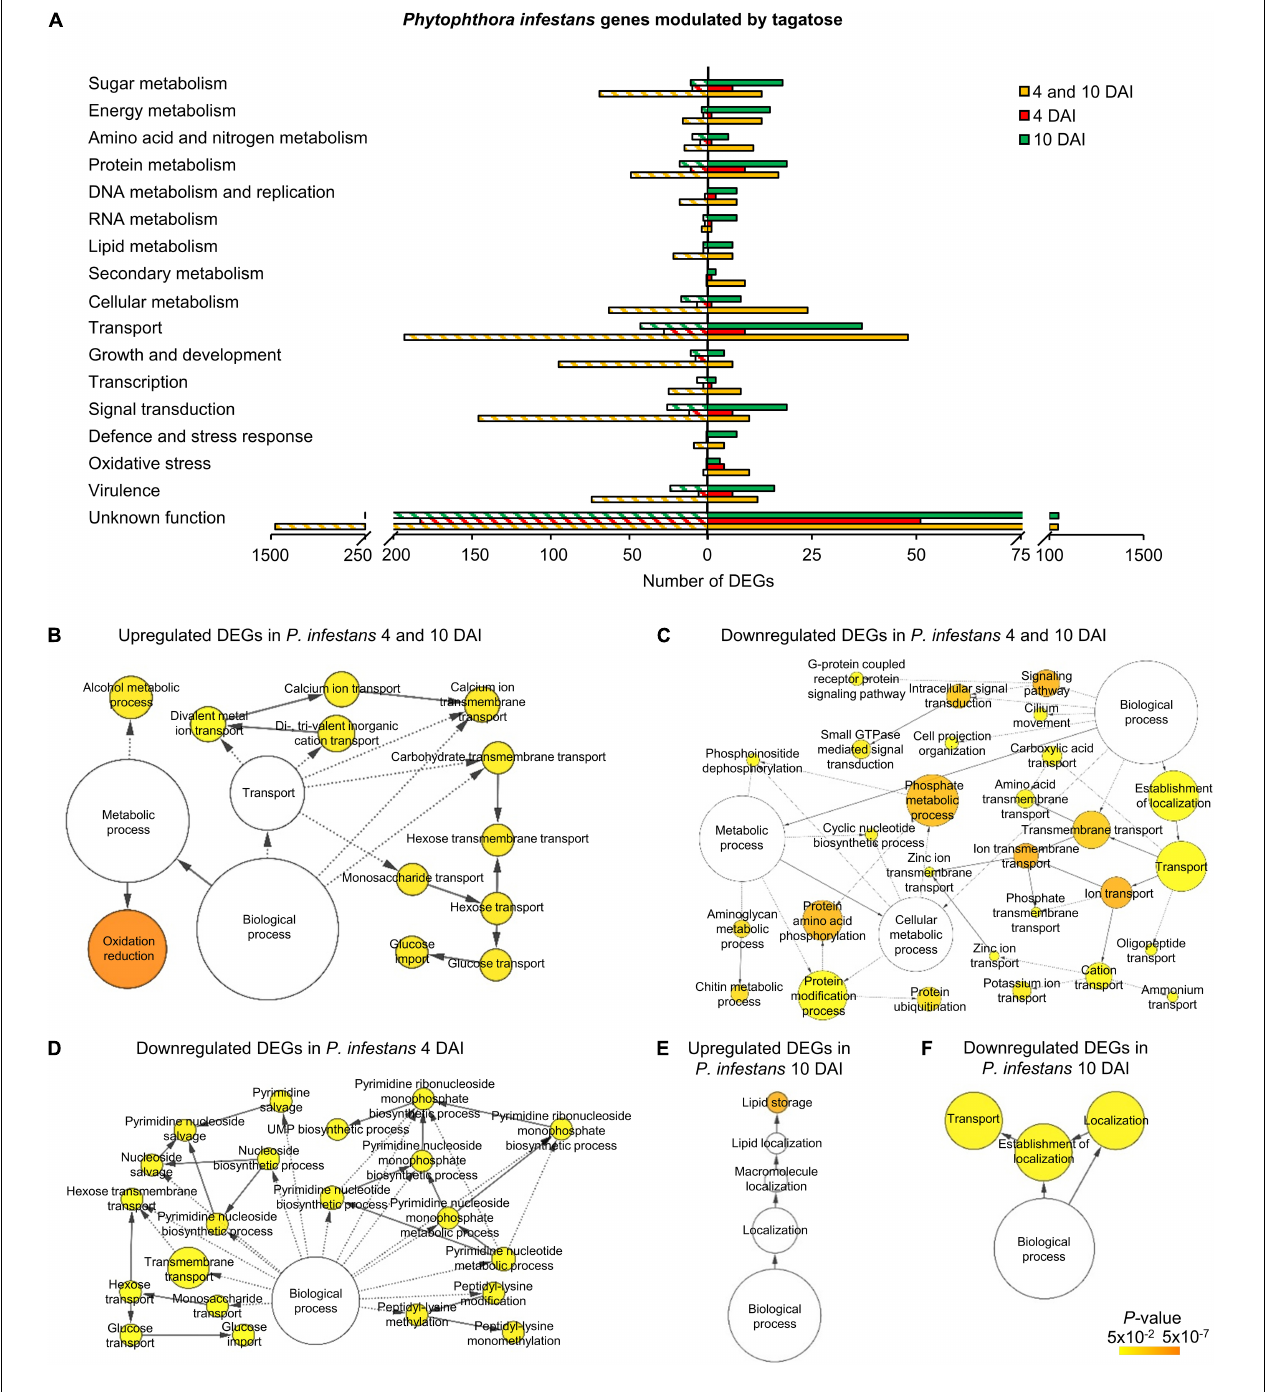
FIGURE 3 | Functional annotation of genes modulated by tagatose in P. infestans . Differentially expressed genes (DEGs) were identified in P. infestans at 4 and 10 days after incubation (DAI) on pea agar medium in the presence of tagatose compared to the respective control samples grown in the absence of tagatose. Functional categories (A) were assigned based on the protein description of upregulated (solid bars) or downregulated (stripped bars) genes at both time points (4 and 10 DAI; orange) and exclusively at 4 DAI (red) or at 10 DAI (green; Supplementary Table 9 ). Biological networks of significantly enriched ( P ≤ 0.05) Gene Ontology (GO) terms of P. infestans genes upregulated at 4 and 10 DAI (B) , downregulated at 4 and 10 DAI (C) , downregulated at 4 DAI (D) , upregulated at 10 DAI (E) and downregulated at 10 DAI (F) were identified using the BiNGO tool and visualized with Cytoscape software. The color scale legend indicates the level of significance for enriched GO terms and white nodes indicate not significantly overrepresented categories. Dotted lines indicate connection between biological process categories in the GO chart, where ancestor and child are omitted for simplicity. No significant GO enrichment was found for P. infestans genes upregulated at 4